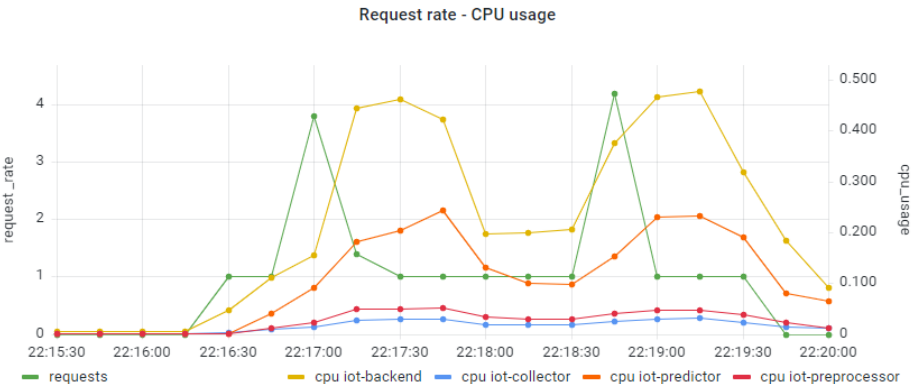
Figure 13. CPU usage per application component under the bursty